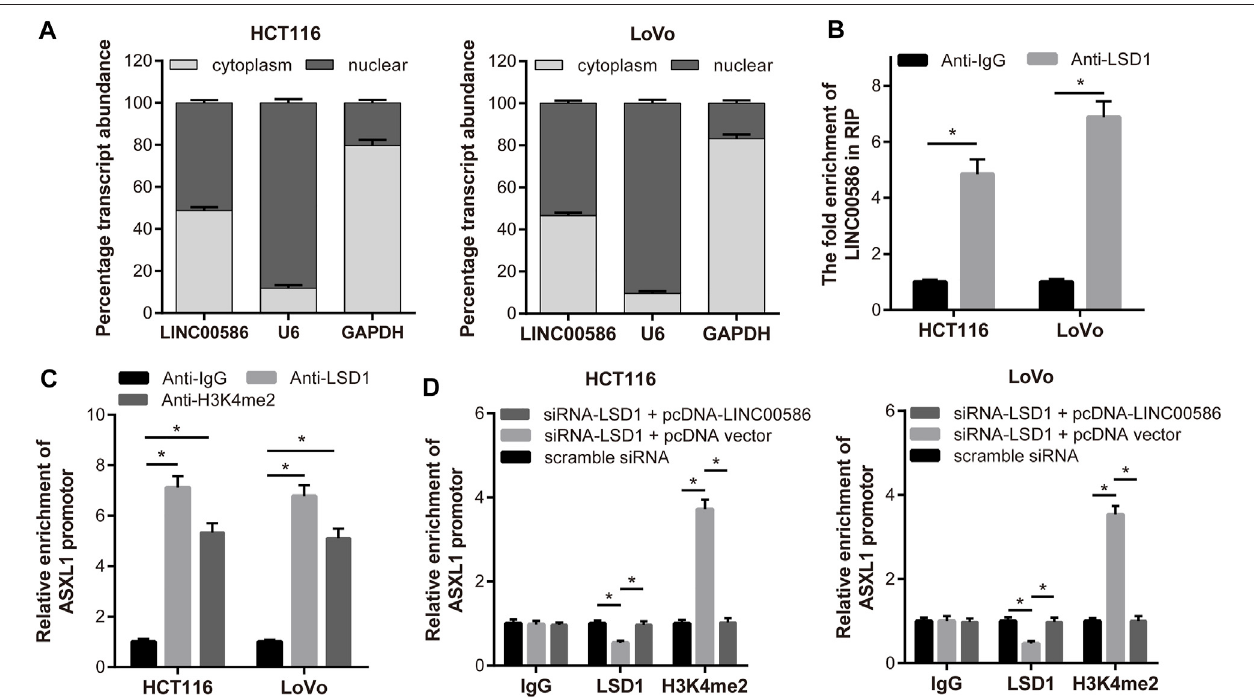
FIGURE 4 | LINC00586 epigenetically silenced ASXL1 transcription through LSD1-mediated H3K4me2 demethylation. (A) Relative LINC00586 expression levels in nuclear and cytosolic fractions of HCTl16 and LoVo cells were determined by real-time qPCR. Nuclear controls: U6; Cytosolic controls: GAPDH. (B) RIP assay was performed to determine LINC00586 binding with LSD1. A signi fi cant enrichment of endogenous LINC00586 was detected in the anti-LSD1 RIP fraction (relative to nonspeci fi cIgGcontrol)inHCTl16andLoVocells. (C) HCTl16andLoVocellsweresubjecttoChIP-PCRassaysusinganti-LSD1,anti-H3K4me2ornonspeci fi cIgG control for ASXL1 enrichment. (D) ChIP-PCR assays of ASXL1 enrichment in HCTl16 and LoVo cells following LSD1 knockdown and/or LINC00586 overexpression. * p < 0.05 by unpaired t test or by one-way ANOVA with Tukey ’ s